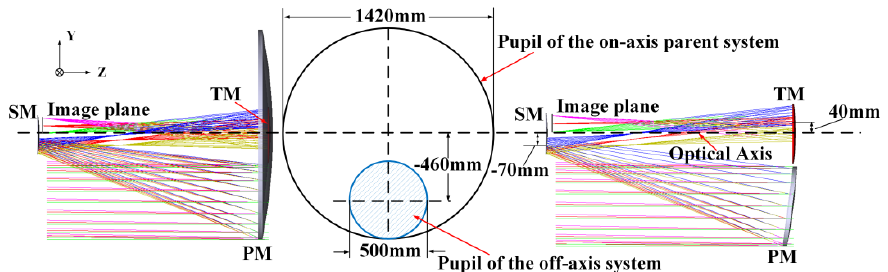
Figure 1. The optical path structure of the off-axis TMA telescope and pupil transformation rela- tionship with its on-axis parent system. ship with its on-axis parent